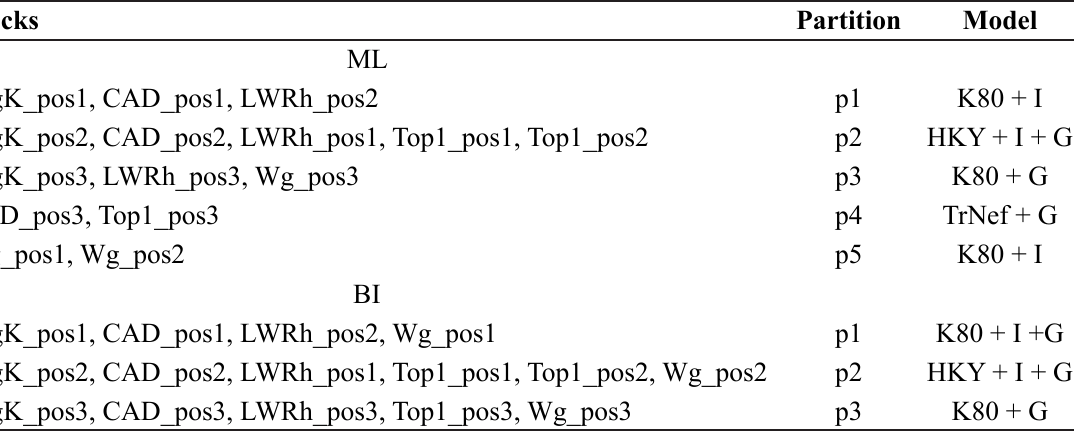
Table 1. Partitions and models identified by PartitionFinder and used in the maximum likelihood (ML) and Bayesian (BI)